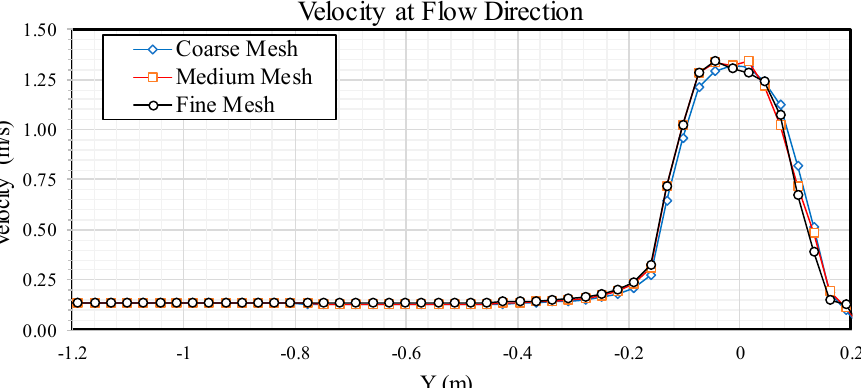
Figure 7. Velocity at line parallel to flow.